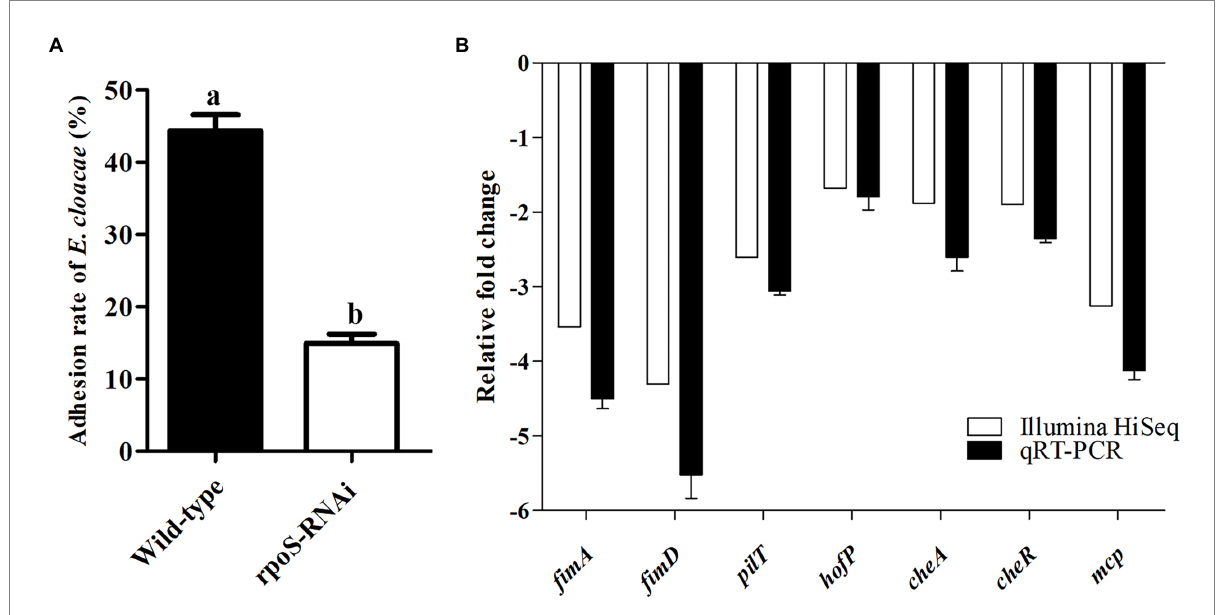
FIGURE 6 Effects of rpoS on adhesion of Enterobacter cloacae . (A) The adhesion rate of E. cloacae wild-type and rpoS -RNAi strains to 293 T cells; (B) Expressions of adhesion-related genes in rpoS -RNAi strain; The values marked with different letters (a, b) are significantly different ( p <